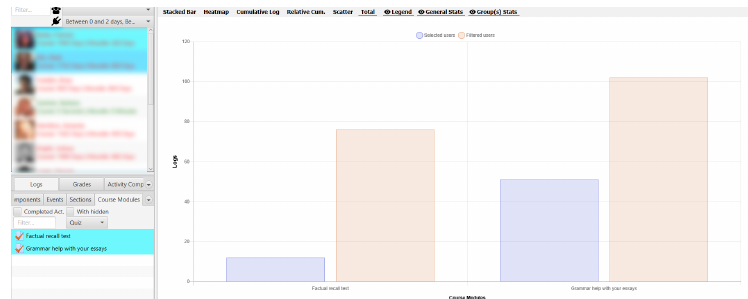
Figure 12. Comparison of access to quizzes.